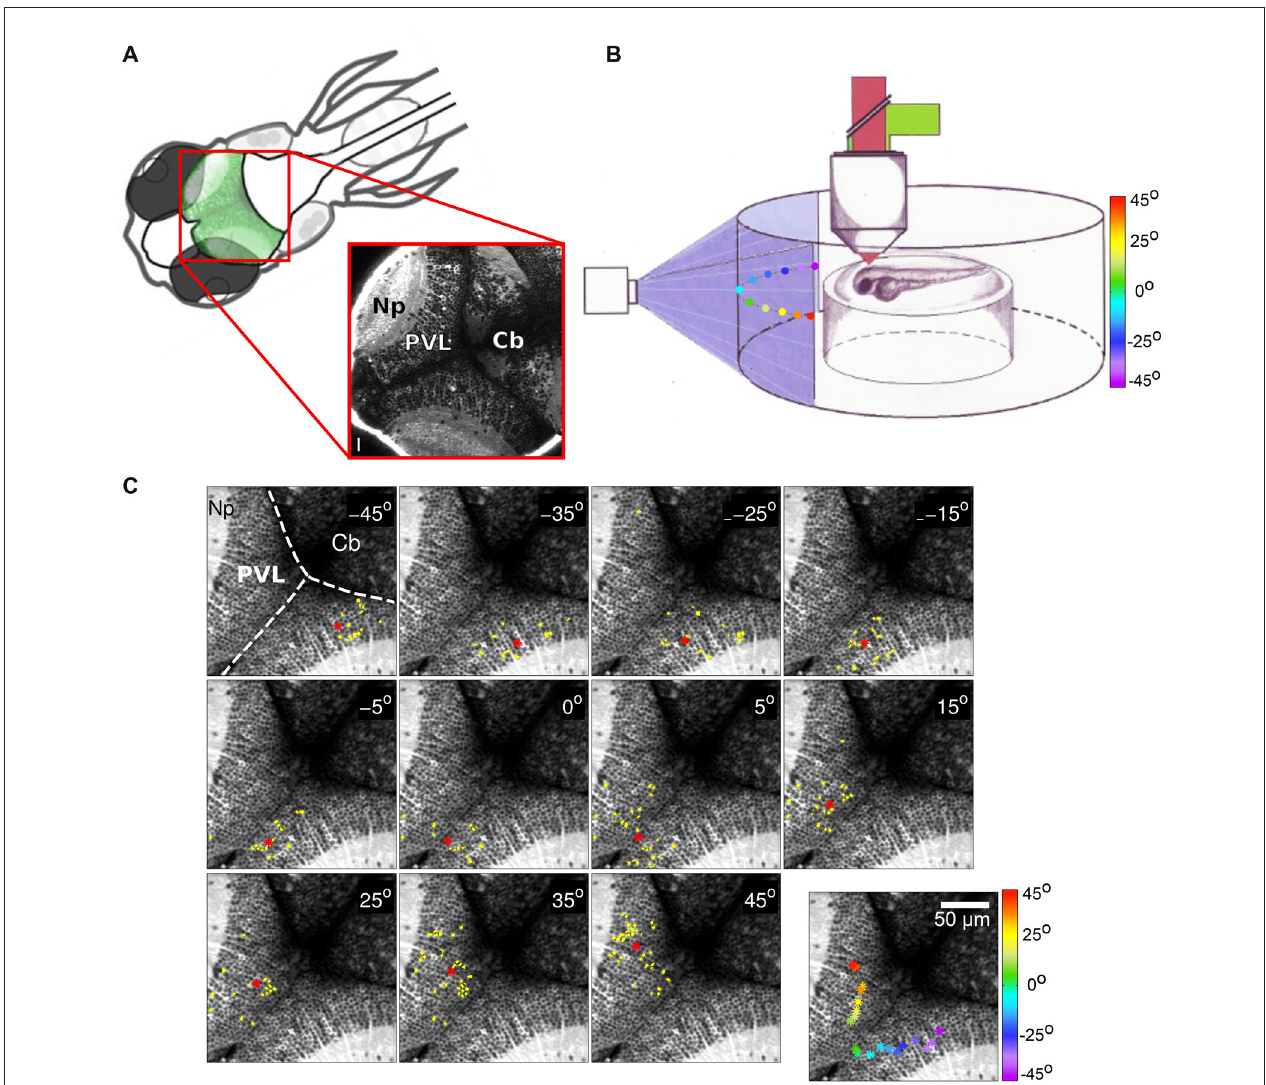
FIGURE 1 | (A) Top left: schematic dorsal view of an 8-days-post-fertilization (dpf) zebrafish larva. The optic tectum is indicated in green. Bottom right: optical section of a Tg(huC:GCaMP5G) zebrafish larva showing pan-neuronal GCaMP5 expression corresponding to the area in the top left scheme (red rectangle). The image was obtained using a two-photon microscope. PVZ, Periventricular layer; Np, neuropil; Cb, cerebellum. Scalebar: 15 µ m (reproduced with permission from Pietri et al., 2017). (B) Schematic drawing of an agarose-embedded zebrafish larvae in the recording chamber. The colored dots represent the different stimuli positions projected on a screen (color scale). (C) Examples of neuronal groups consistently activated by light spots at different positions in the field of view of the larva (azimuth angle, top right corner). Activated neurons are colored in yellow, and the neuronal groups’ centroids are depicted as red asterisks. Top left: anatomical landmarks. Dashed lines delineate the tectal-cerebellar and inter-hemispheric tectal boundaries. Cb, cerebellum; Np, tectal neuropil; PVL, periventricular layer. Bottom right panel: the centroids colored according to the azimuth angle (color bar on the right). The centroids evenly tile the contra-lateral rostro-caudal (reproduced with permission from Romano et al.,